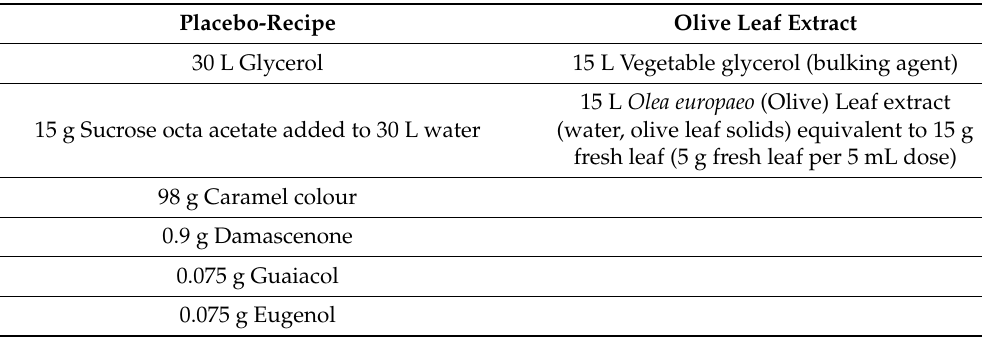
Table A2. Ingredients for placebo and OLE supplement.